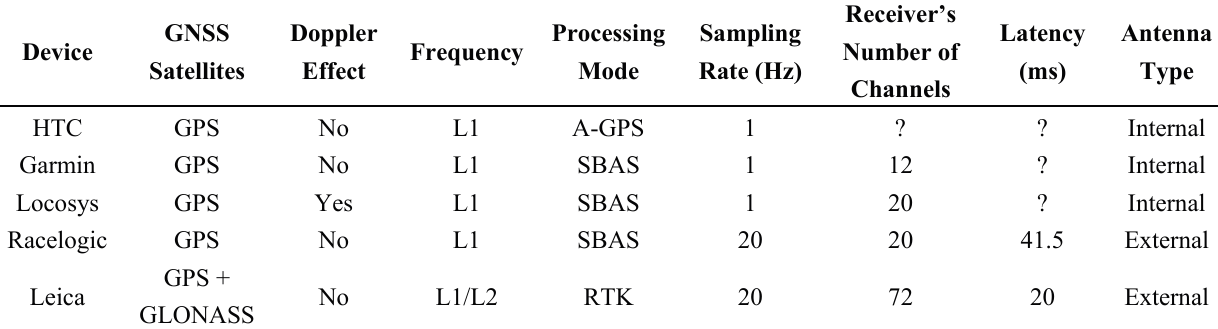
Table 1. Selected technical specifications of the GNSS devices. Legend: GNSS—Global Navigation Satellite System; GPS—Global Positioning System; GLONASS—Globalnaja Navigacionnaja Sputnikovaja System; A-GPS—Assisted GPS; SBAS—Satellite-Based Augmentation System; RTK—Real Time